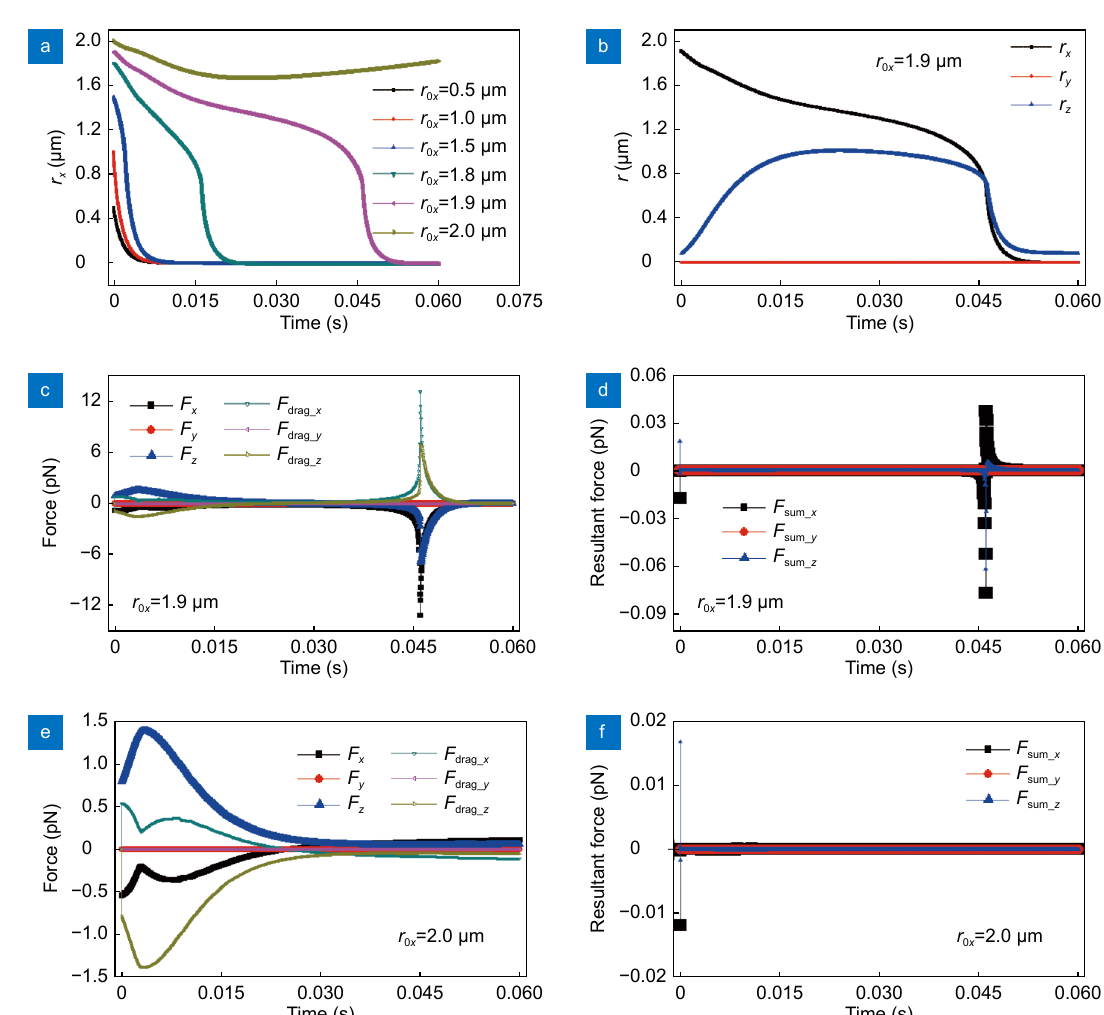
Fig. 3 | Mechanical motion dynamics of the micro-sphere at different initial positions in the horizontal trapping plane. ( a ) The x -direction- al trajectories of the micro-sphere at different initial positions in the x -axis in the optical tweezers with r 0 x =0.5, 1.0, 1.5, 1.8, 1.9, and 2.0 μm. ( b )−( d ) display the temporal evolution of the x - and y - and z - directional trajectory, optical force, drag force, and resultant force, respectively, when the micro-sphere is set at the initial position r 0 x =1.9 μm. ( e ) and ( f ) display the temporal evolution of the optical force and the drag force, and the resultant force, respectively, when r 0 x =2.0